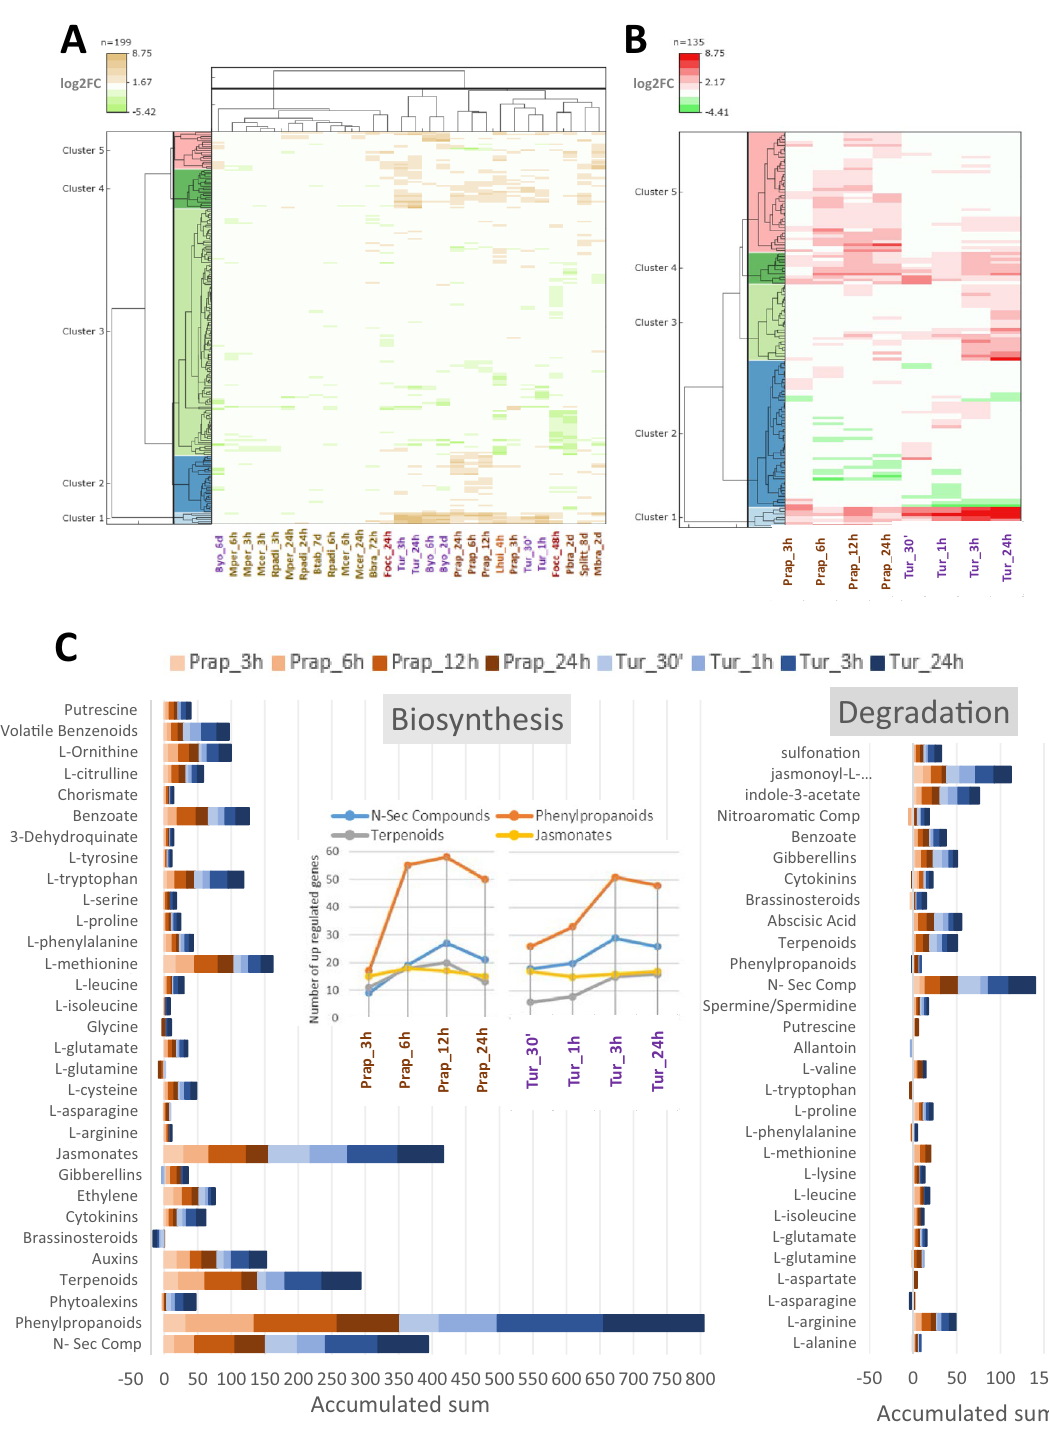
Figure 5. Analysis of the transcriptomic changes in the genes associated to secondary metabolic pathways. ( A ) Heatmap showing the transcriptomic profile of the DEGs belonging to secondary metabolism categories and detected at least in one experiment. ( B ) Heatmap restricted to the DEGs in T. urticae and P. rapae experiments. ( C ) Number of DEGs and their accumulated expression from the secondary metabolism categories at four time points of infestation by P. rapae or T. urticae